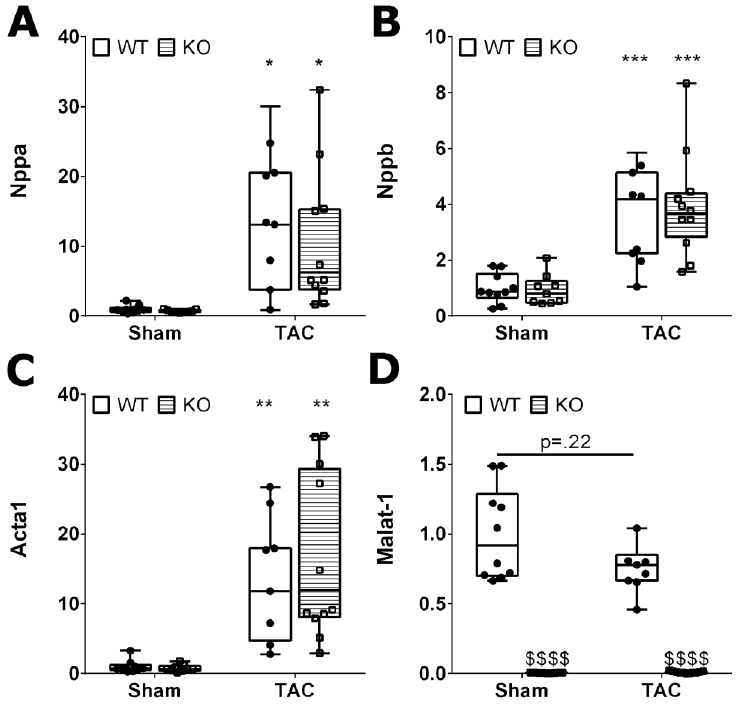
Fig 3. mRNA levels of hypertrophy markers. The hypertrophy marker genes Nppa (A), Nppb (B) and Acta1 (C) were upregulated by TAC and not different between Malat-1 WT and KO mice. (D) Malat-1 itself was not significantly deregulated after TAC. * p < 0.05, ** p < 0.01, *** p < 0.001 TAC versus Sham; $$$$ p < 0.0001 KO versus